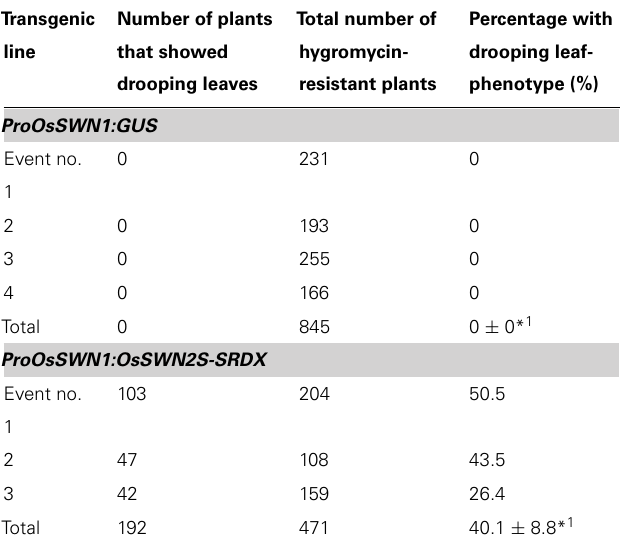
Table 2 | Drooping leaf phenotype of the ProOsSWN1: OsSWN2S-SRDX rice plants. Transgenic line drooping leaf-